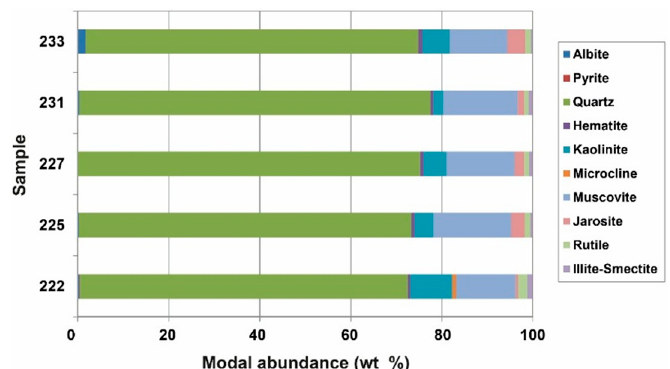
Figure 2. Bulk mineralogy (measured by XRD) results for samples selected from heap leach Piles 1 and 2 ( n = 5; samples: 222, 225, 227, 231 and 233; detection limit: ~1 wt %).